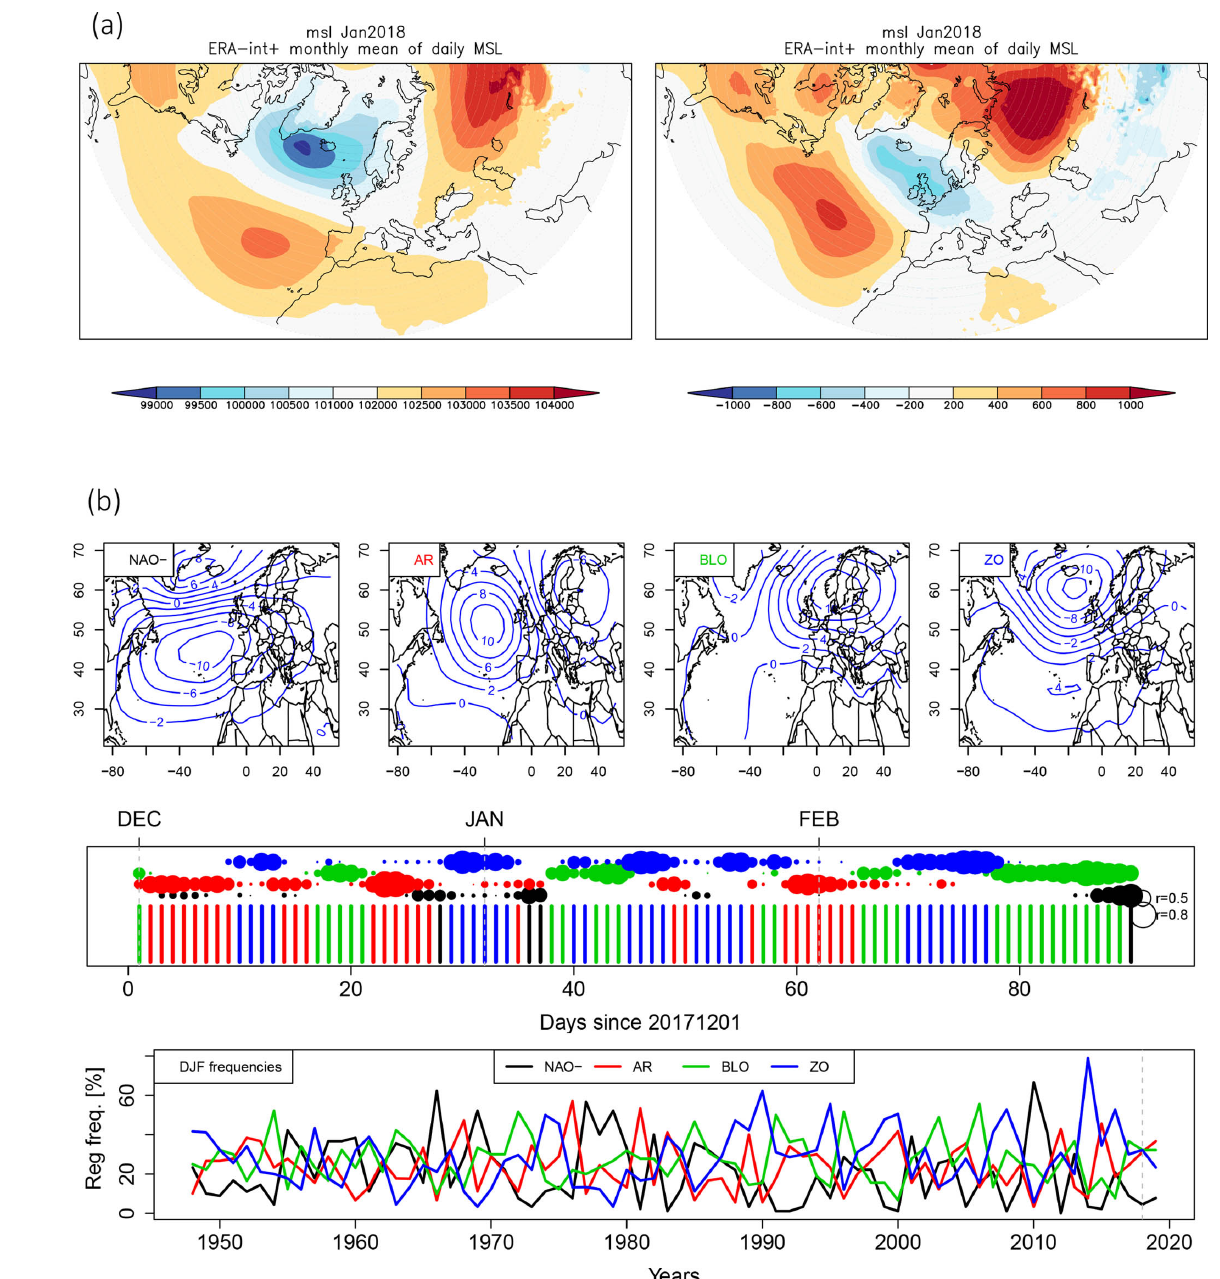
Figure 2. (a) Sea level pressure (left) and anomaly (right) (ECMWF analysis, ERA-Interim climatology); (b) first row: weather regime cluster centroids from NCAR/NCEP reanalysis; second row: occurrence of weather regimes from 1 December 2017 to 28 February 2018; the vertical bars indicate the preferred centroid (NAO-; Atlantic Ridge, AR; Scandinavian Blocking, BLO; Zonal, ZO) and the coloured circles indicate the spatial correlation with the preferred centroid; third row: weather regime wintertime frequencies from 1948 to